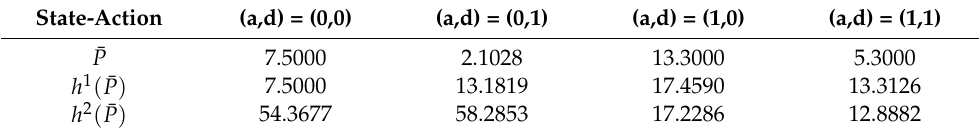
Table 6. Convergent Q -table based on SARSA, considering the game of sensor and